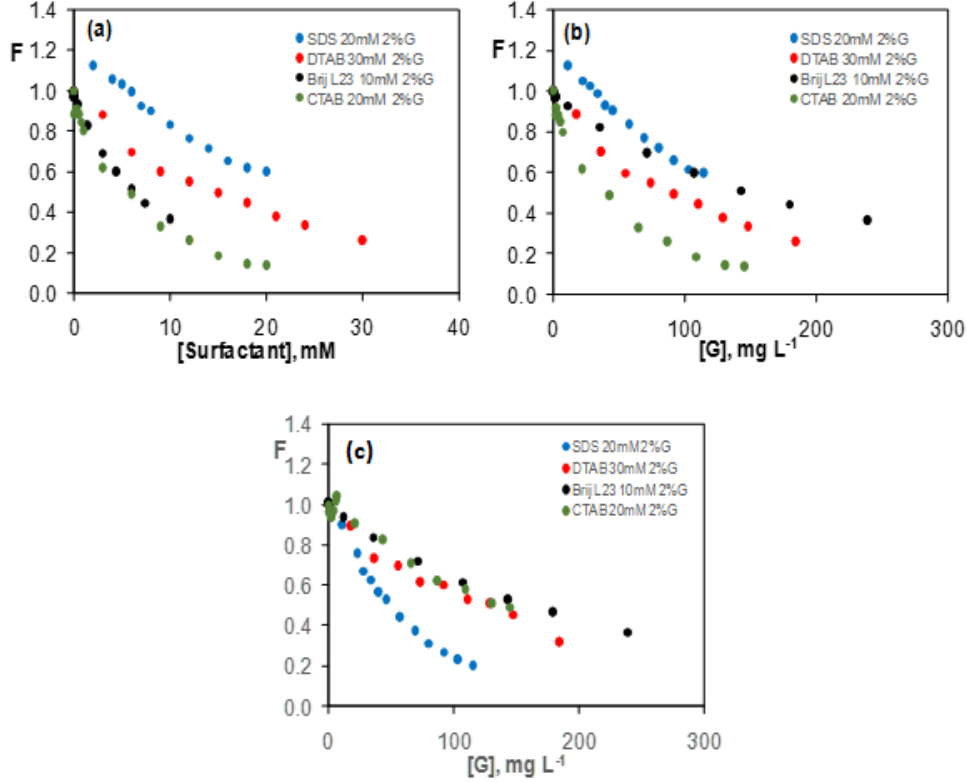
Figure 9. Comparison of the quenching effect ( λ exc = 325 nm; λ em = 395 nm) for G (2 wt %) dispersions in the indicated surfactant solutions vs. surfactant ( a ) or G ( b , c ) concentration, for dispersions with a constant w G /w S ( a , b ) or a constant surfactant concentration ( c ).